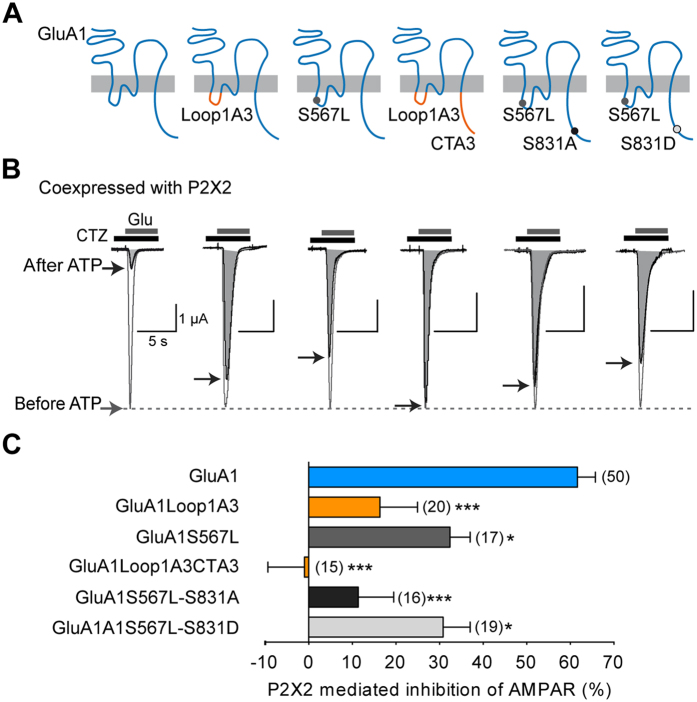
S567 and S831 residues of GluA1 are involved in the P2X2-mediated AMPAR current inhibition.(A) Schematic representation of chimeric or mutant GluA1 receptors of the first intracellular loop and CT of GluA1. (B) Surimposed glutamate-evoked currents before and after ATP-induced P2X2R current recorded in the same conditions described in Fig. 2 for oocytes co-expressing P2X2R and the corresponding modified GluA1 subunits. Maximal amplitudes of AMPAR currents after ATP (shaded areas) are indicated by black arrows. (C) Bar graphs showing the percentage of P2X2-mediated AMPAR current inhibition for wild-type GluA1 and chimeric or mutated GluA1 receptors. Statistical differences compared to GluA1 are indicated. *p < 0.05; ***p < 0.001; Numbers of cells are indicated in parentheses.